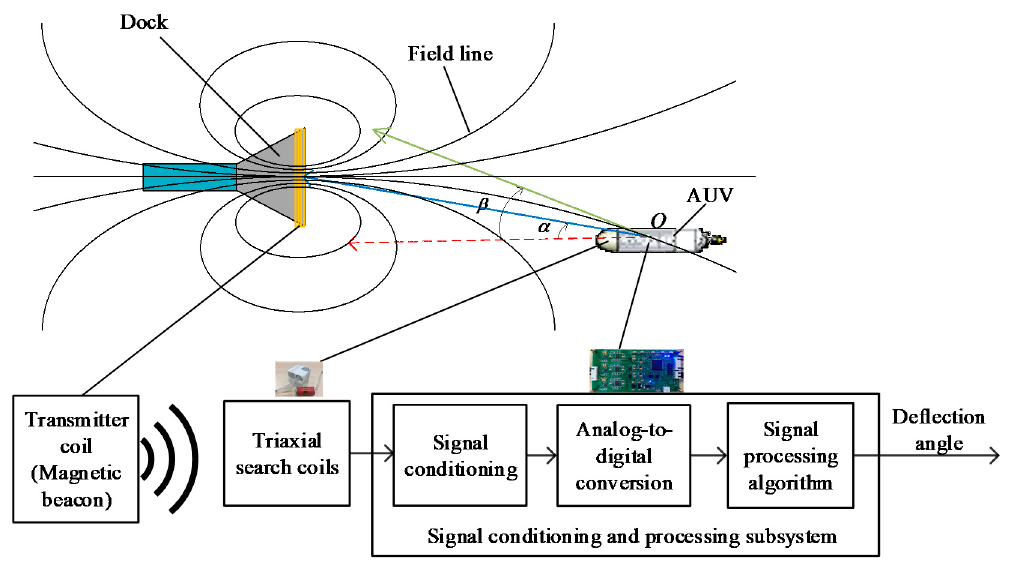
Figure 1. Schematic of AUV docking via electromagnetic (EM) guidance and structure of electromagnetic docking guidance (EMDG) system.